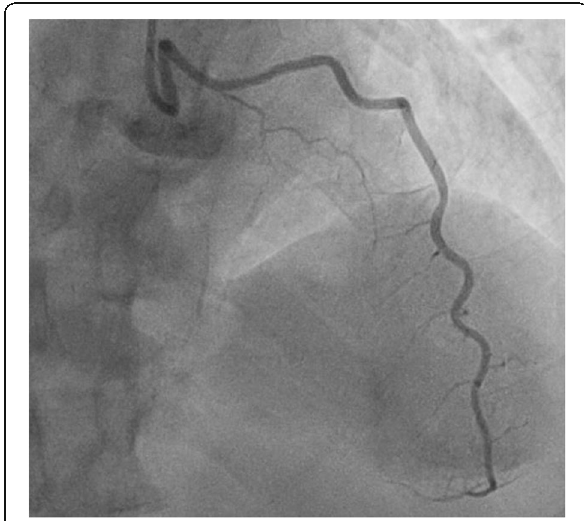
Fig. 4 LAO cranial view with a selective injection demonstrating long LAD continuing till apex giving small septal